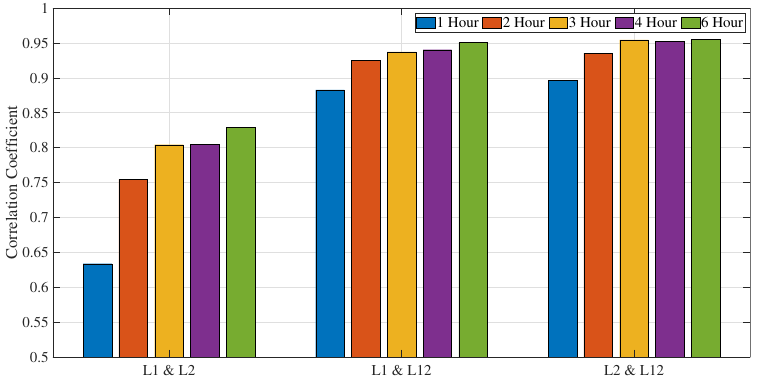
Figure 8. Correlation coefficient of different legacy solutions for different sub-daily resolutions.